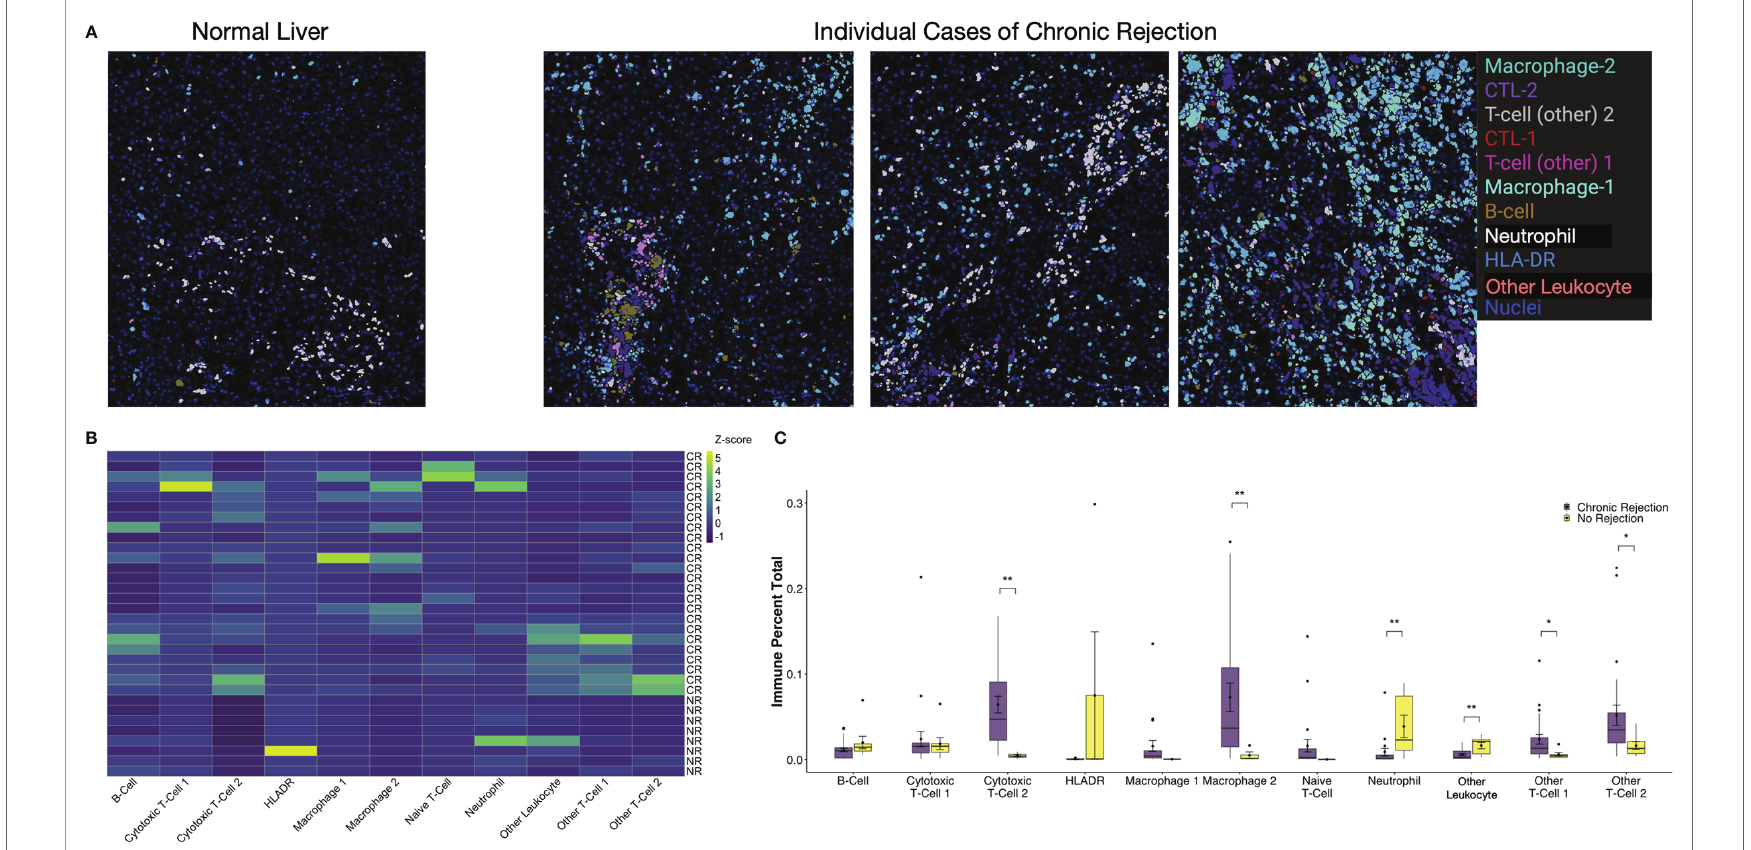
FIGURE 4 | Visualization and quanti fi cation of immune subpopulations involved in chronic liver transplant rejection. (A) Histopathological examination of immune subpopulations identi fi ed via Phenograph analysis was completed by creating single-cell masks labeled by speci fi c immune cell meta-cluster. Representative images depict liver with no rejection and three unique patients with chronic rejection. (B) The relative frequency of speci fi c immune subpopulations in individual regions of interest for no rejection (NR) and chronic rejection (CR) across the study population standardized within subpopulation using z- scores, where the zero-point is the average cell frequency within that subpopulation. Color scale shows z-score per column. (C) Quanti fi cation of each immune subpopulation revealed signi fi cant increases in the following subpopulations in chronic rejection when compared to liver with no rejection: Cytotoxic T-cell 2, Granulocytes, Macrophage 2, Other T-cell 1 and Other T-cell 2 (*p < 0.05, **p < 0.01 for comparisons between NR and